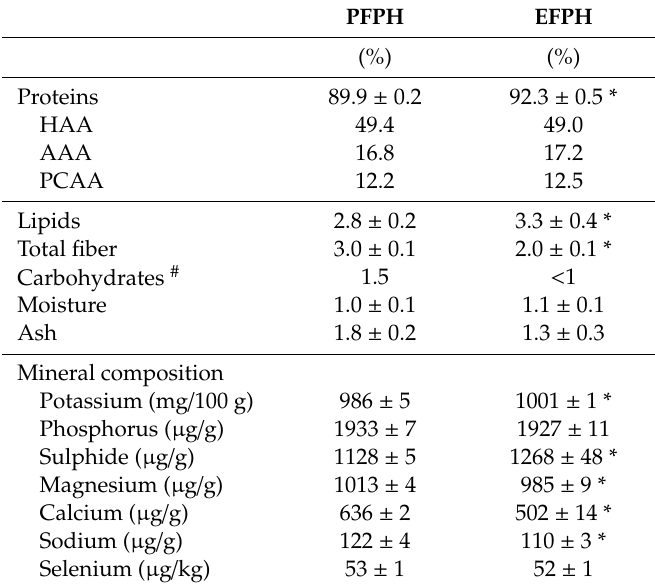
PFPH: Purafect fenugreek proteins hydrolysate. EFPH: Esperase fenugreek proteins hydrolysate. HAA: hydrophobic amino acids (Ala, Val, Ile, Leu, Tyr, Phe, Trp, Pro, Met, and Cys). AAA: aromatic amino acids (Phe, Tyr, Trp). PCAA: positively charged amino acids (Arg, His, Lys). Results are presented as mean ± SD ( n = 3). Superscripted (*) means within a row are significantly di ff erent ( p ≤ 0.05). #: Calculated by di ff